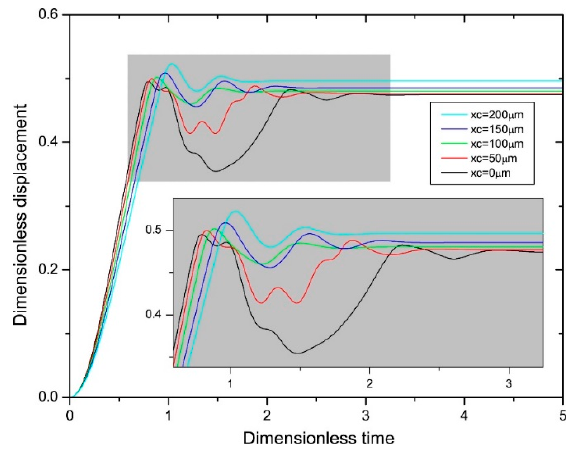
Figure 5. The simulated dynamic responses of the conventional and proposed MEMS relay of di ff erent contact electrode positions.